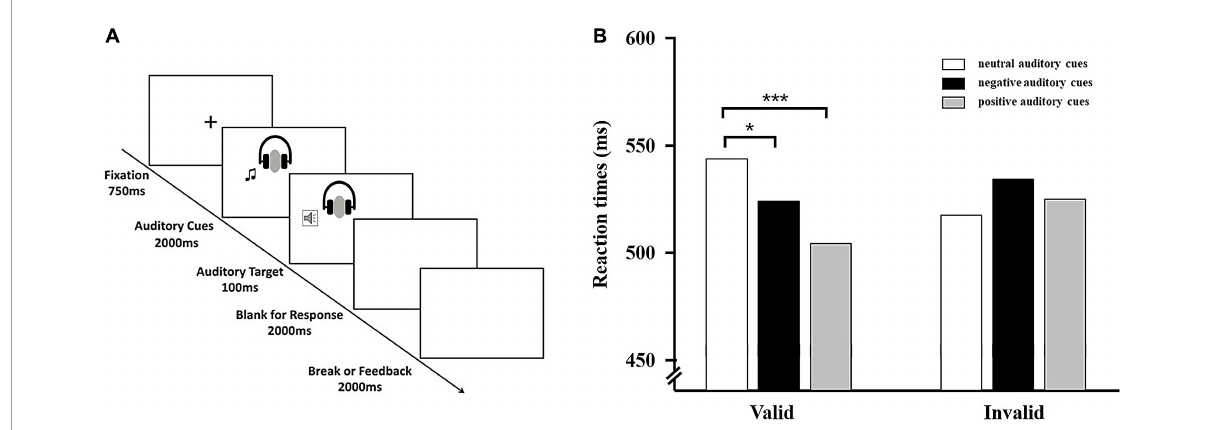
FIGURE1 (A) Typical sequence of Experiment 1. Shown in the figure is an example of a valid trail. Emotional cues (positive, negative, or neutral) were presented equally often to the right or left ear and were followed by the target on the same (valid, 50%) or opposite side of space where the cue was presented (invalid, 50%). (B) Behavioral results from Experiment 1. Average reaction times for the six experimental conditions. Error bars indicate standard error (SE) of the mean. * p < 0.05; *** p <